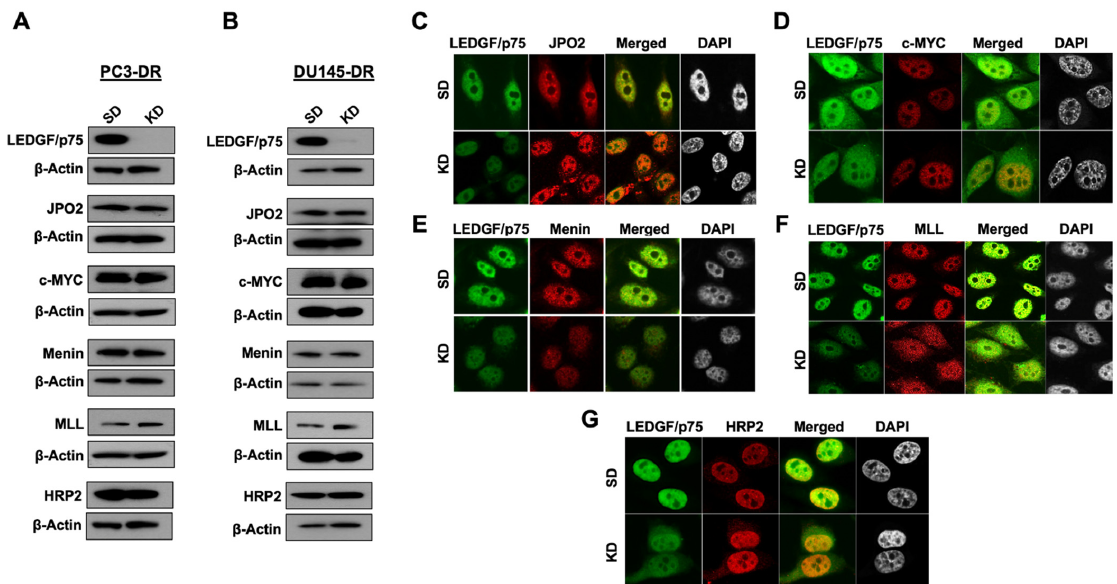
Figure 6. LEDGF/p75 depletion does not alter the protein expression of selected IBD interacting partners in DTX-resistant cells but affects their nuclear localization patterns. LEDGF/p75 knockdown was assessed by immunoblotting using a rabbit anti-LEDGF/p75 antibody in PC3-DR ( A ) and DU145-DR ( B ) cells transfected with siLEDGF/p75 (KD) or scrambled duplex (SD) control oligos. Representative blots show that the protein expression levels of JPO2, c-MYC, menin, MLL, and HRP2 were not altered by LEDGF/p75 depletion. For confocal microscopy analysis, human anti-LEDGF/p75 autoantibodies were co-incubated with rabbit antibodies to JPO2 ( C ), c-MYC ( D ), menin ( E ), MLL ( F ), and HRP2 ( G ) in DTX-resistant PC3 cells with and without LEDGF/p75 depletion. Detection of nuclear proteins was achieved with FITC-labeled secondary anti-human antibody (green) and rhodamine-labeled secondary anti-rabbit antibody (red). Merged images show the yellow-orange staining typical of co-localization. DAPI was used for nuclear staining.